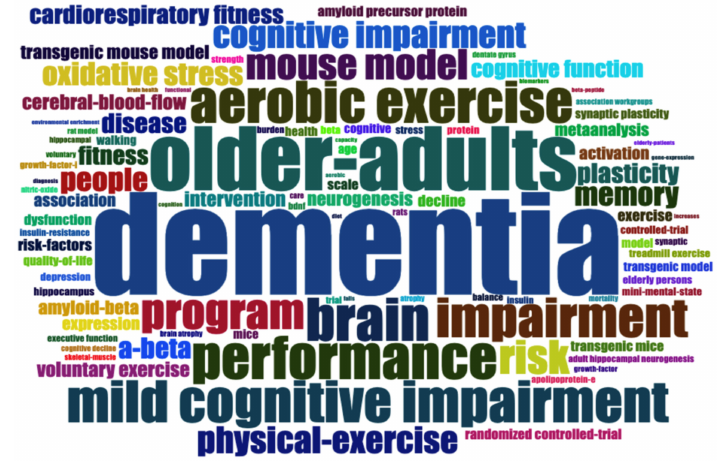
Figure 9. Word cloud visualization of keyword plus terms.